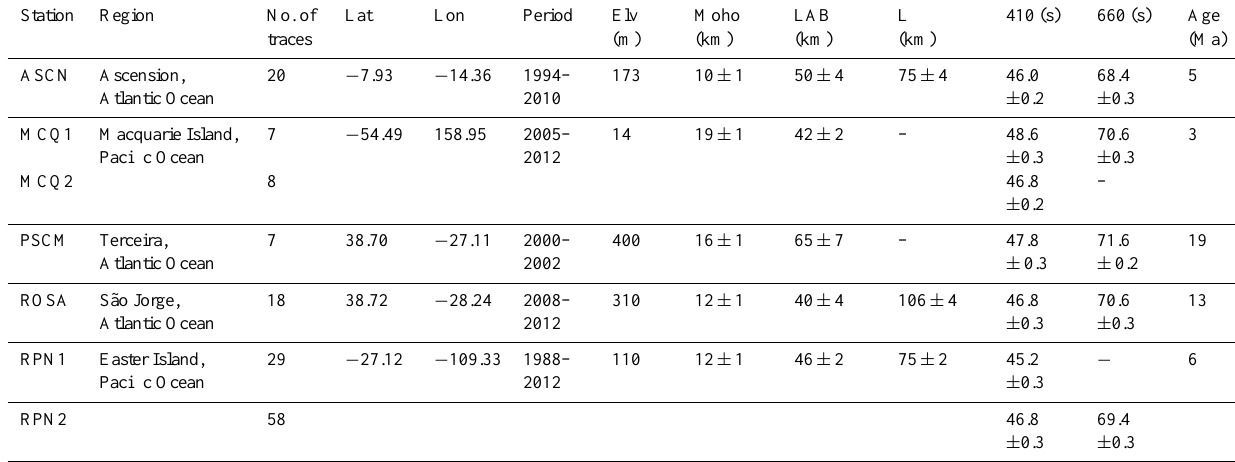
Table 1. The Moho, LAB and LVL depths beneath the stations used in this study, together with the P -to- S conversion times from the upper mantle